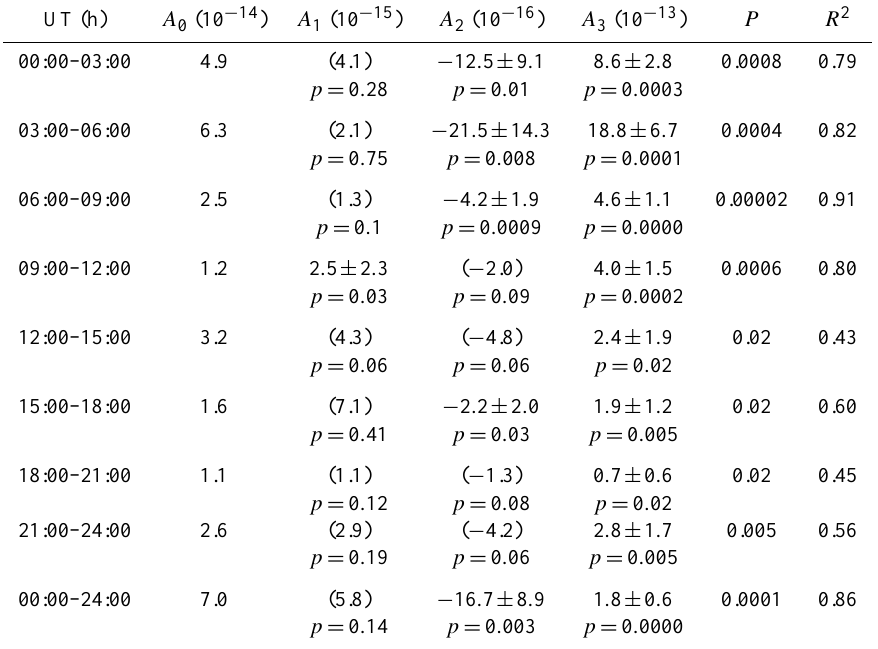
Table 2. The coefficients of multi-parameter regression for year-to-year variation of PMSE η together with their 95% confidence intervals and p-values of F-statistics for testing hypothesis of a zero coefficient. P is the p-value of F-statistic for testing the hypothesis of all zero coefficients and R 2 is the square of the correlation coefficient between original η and the final fit. The parentheses indicate that coefficient was set to zero in the final